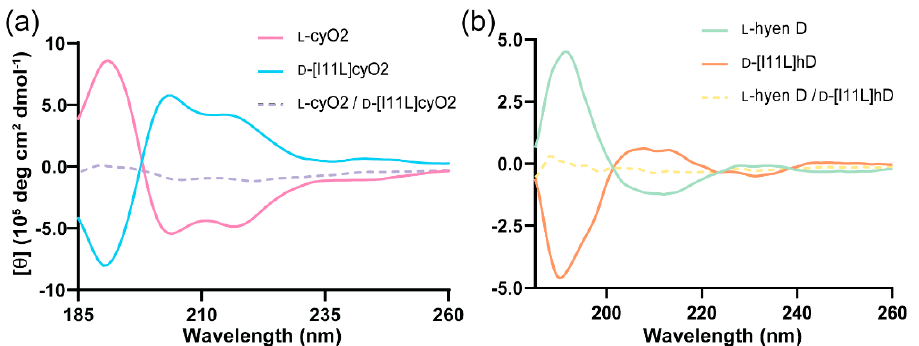
Figure 2. Circular dichroism (CD) spectra of the synthetic D -enantiomers and native ( L -) bracelet cyclotides. ( a ) CD spectra of L -cyO2 (pink) and D -[I11L]cyO2 (blue) at 50 μ M, and their mixture in equal ratio, in dashed line (purple). ( b ) CD spectra of L -hyen D (green) and D -[I11L]hD (orange) at 50 μ M, and their mixture in equal ratio, in dashed line (yellow).